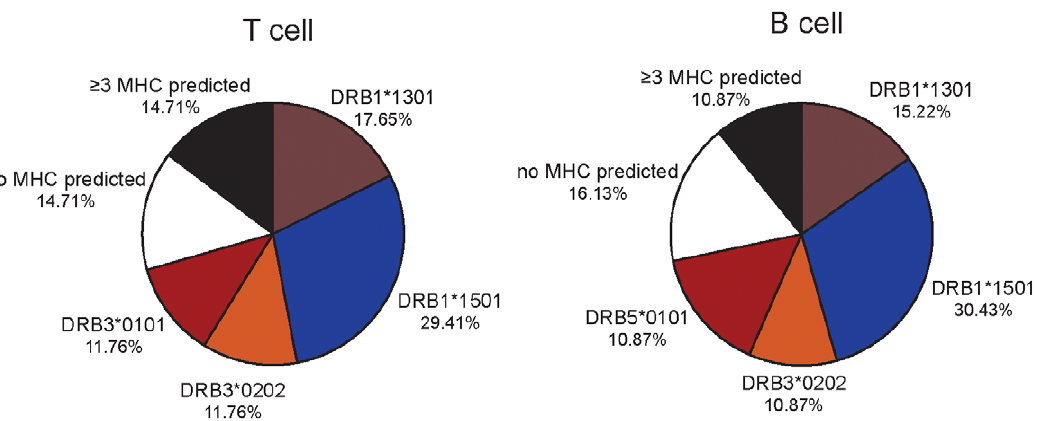
Figure 4. Predicted class II MHC occupancy for self-peptides derived from a single donor with multiple MHC alleles. Peptides with both weak ( , 500 nM) and strong ( , 50 nM) predicted affinity are considered as positive for binding. The large frequency of peptides for which no MHC binding could be predicted or which greater than 3 MHC alleles was predicted suggests the likelihood of MHC promiscuity among self-peptides.